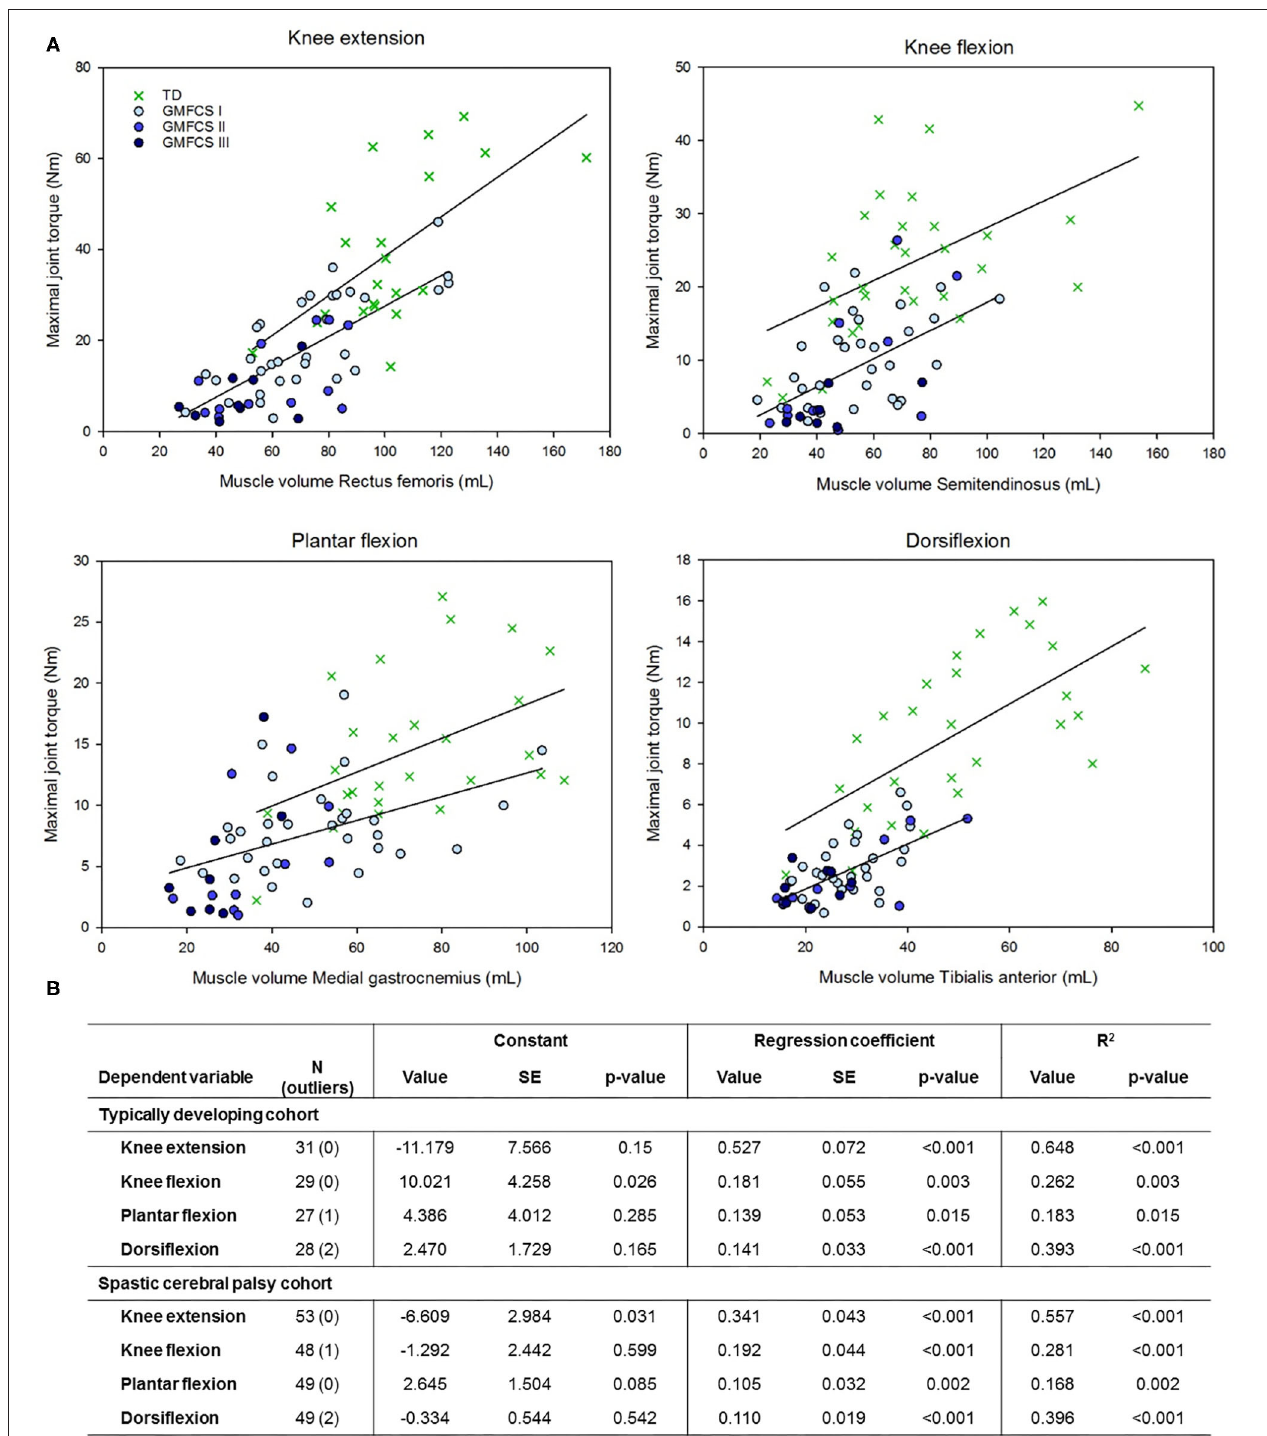
FIGURE 1 | Relationship between muscle volume and maximal joint torque for four lower limb joint movements in children with a typical development (TD) and with spastic cerebral palsy with gross motor function classification scale (GMFCS) levels I to III. (B) Regression formula parameters for the estimation of maximal joint torque based on muscle volume as shown in (A) . SE, standardized error. The outliers indicate the cases that were removed based upon the standardized residuals or Cook’s distance.